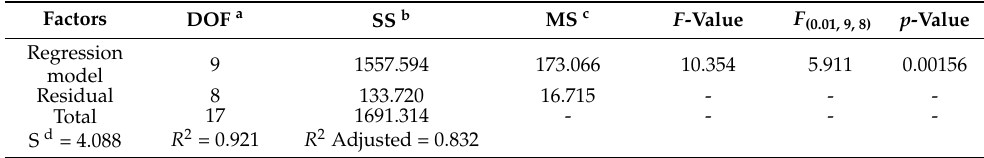
Table 6. Results of ANOVA for the second order polynomial model of tensile strength.